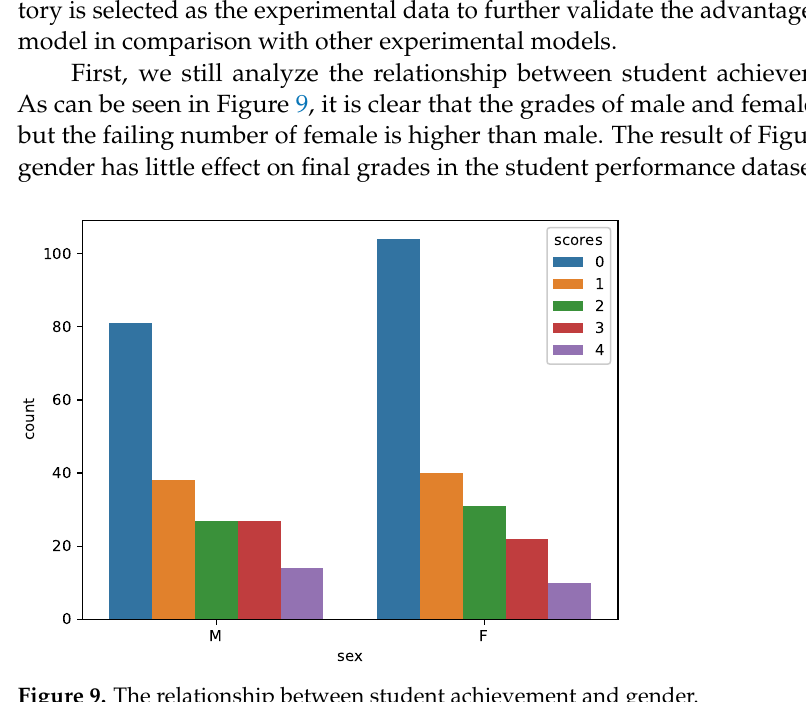
Figure 9. The relationship between student achievement and gender.